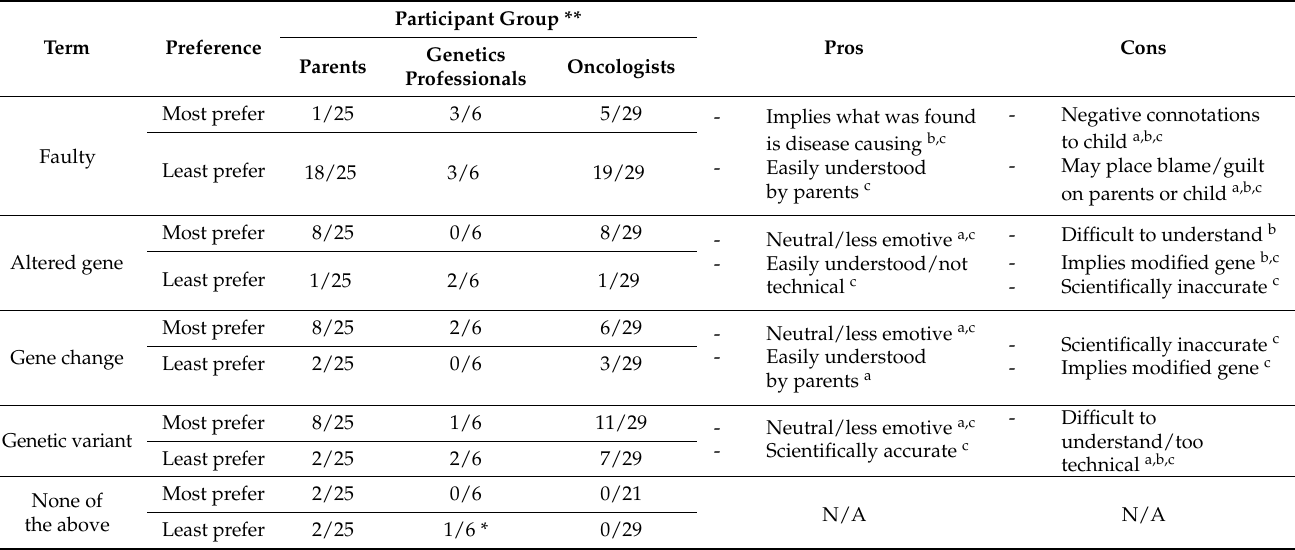
Table 4. Proportion of participants in each participant group who most and least preferred each term ad key reasons